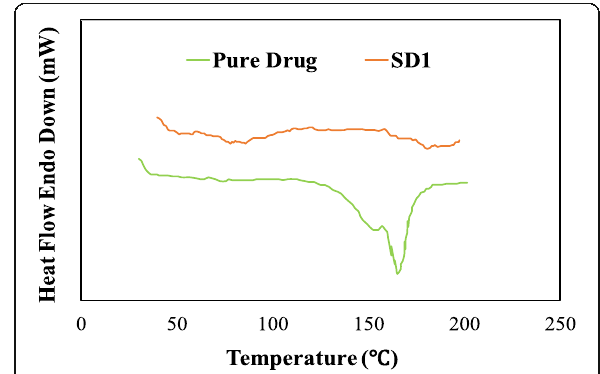
Fig. 6 DSC thermogram of pure drug and SD1